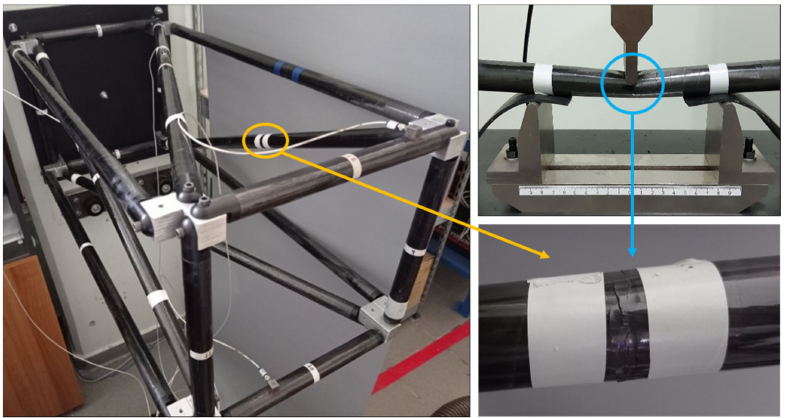
Figure 7. The damaged CFRP tube mounted on one of the four possible positions of the truss ( left ). Damage creation on the CFRP tube with the three‑point bending system ( right